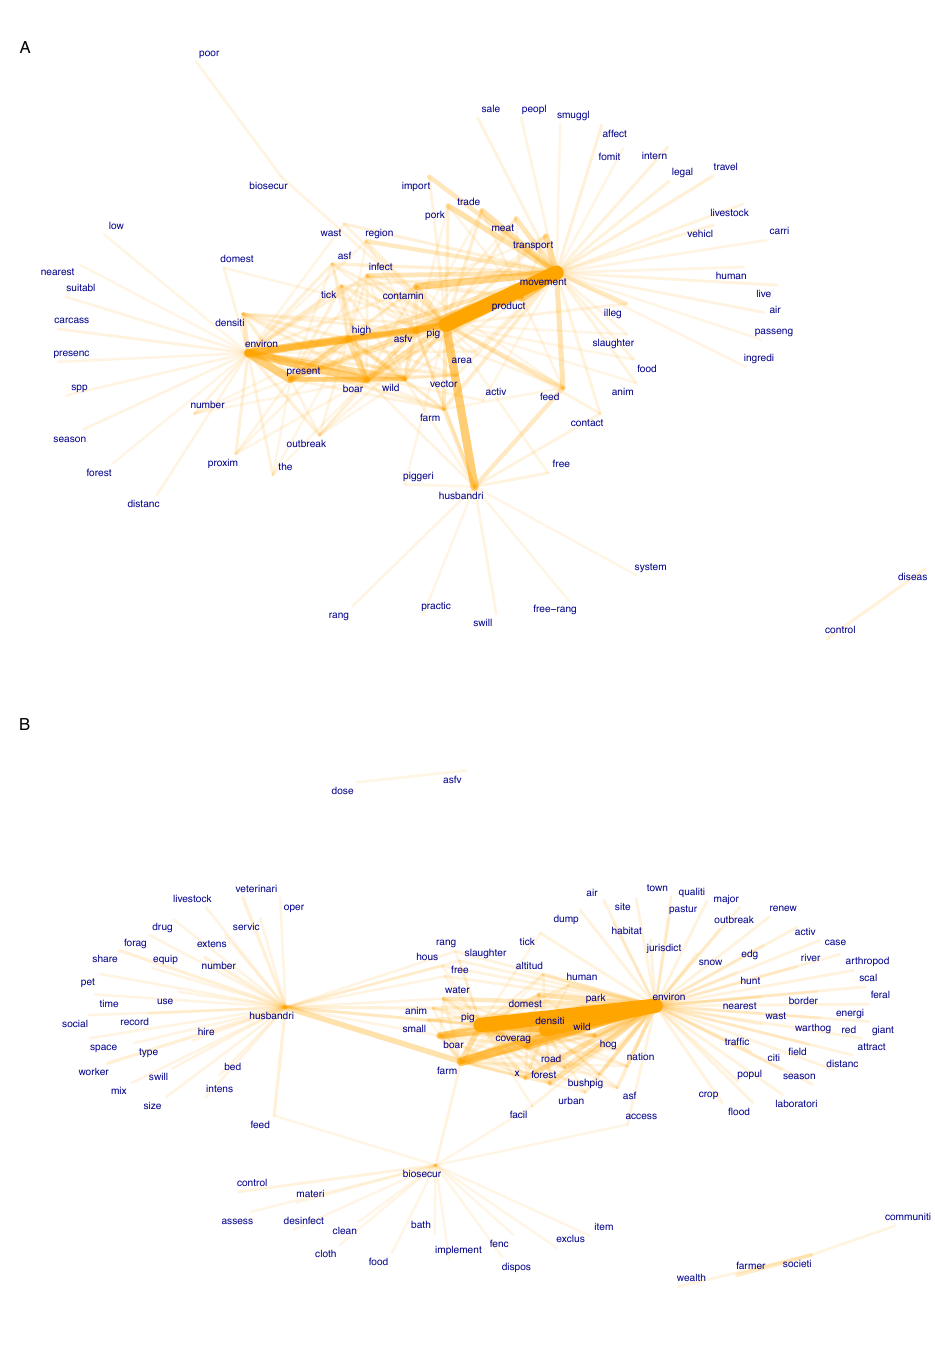
Figure 5. Co-occurrence networks of keyword stems among identified potential ( A ) and observation- based ( B ) ASF risk factors. The top 200 co-occurring words are shown. Orange bar thickness represents the frequency of